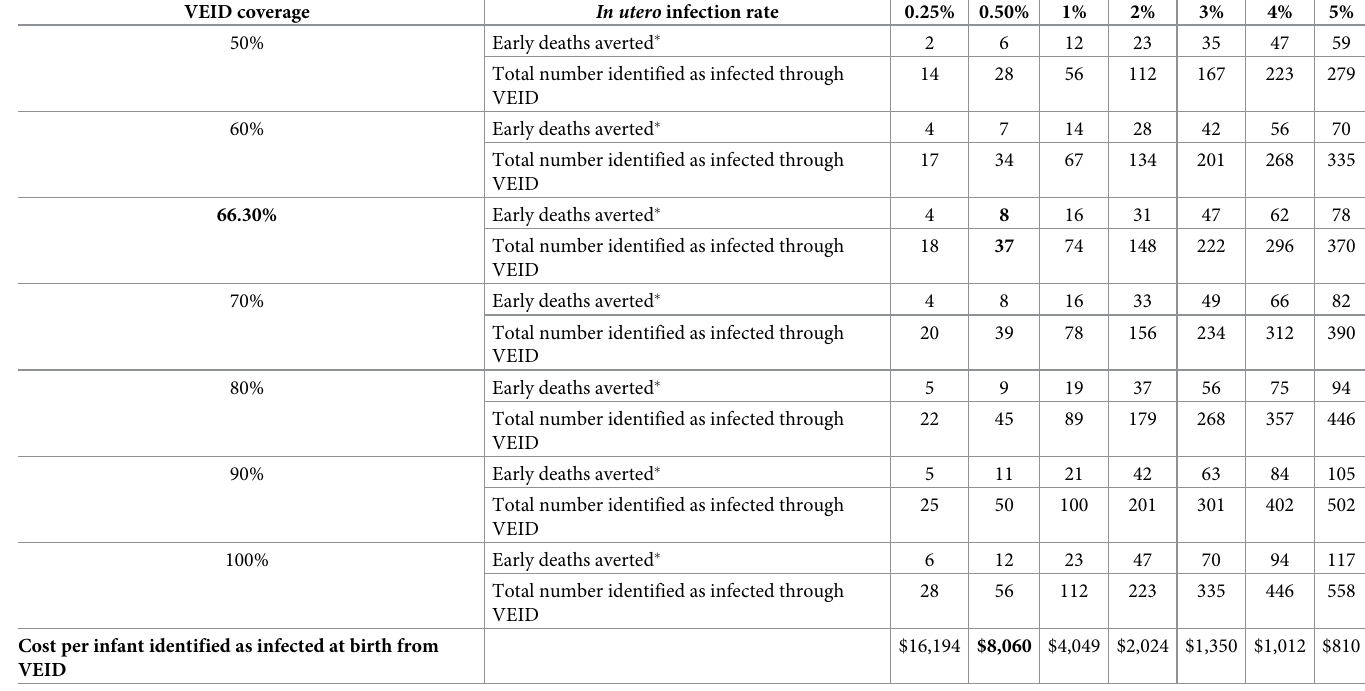
Table 2. Cost outcome of VEID (assuming different epidemic circumstances). Specific parameter values from the Lesotho pilot study are: VEID coverage 66.3%, in utero infection rate 0.50% and the unit cost-per-VEID test of $40.50 is used to calculate the cost per infant identified as infected at birth ($8,060). VEID coverage